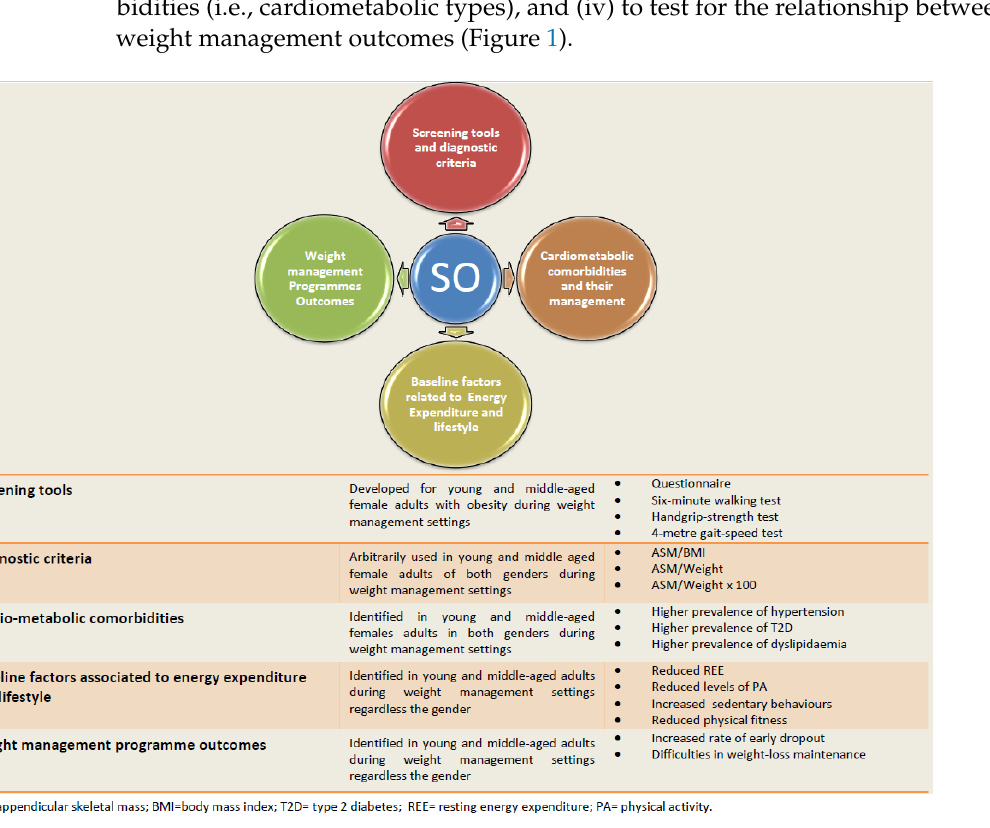
Figure 1. Approaching SO in young and middle-aged female adults during weight management programs .